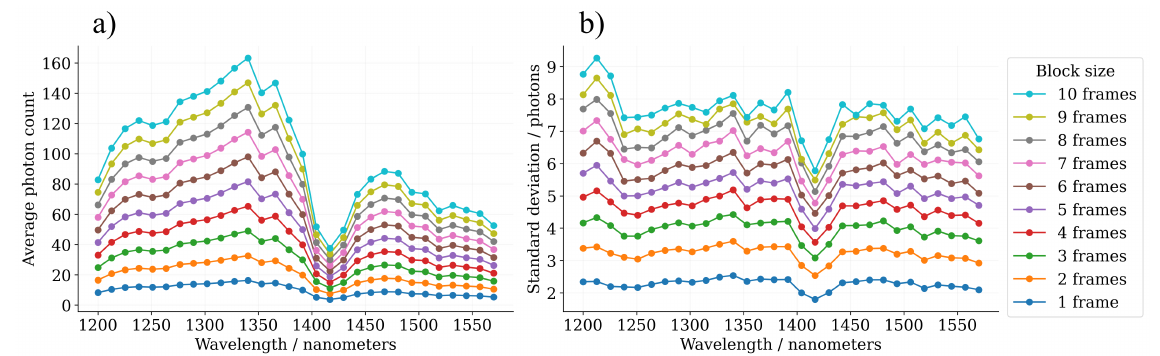
Figure 13. The block-wise ( a ) average photon count and ( b ) photon count standard deviation of the Spectralon 40% target as a function of the block size N frames ∈ [ 1,10 ]